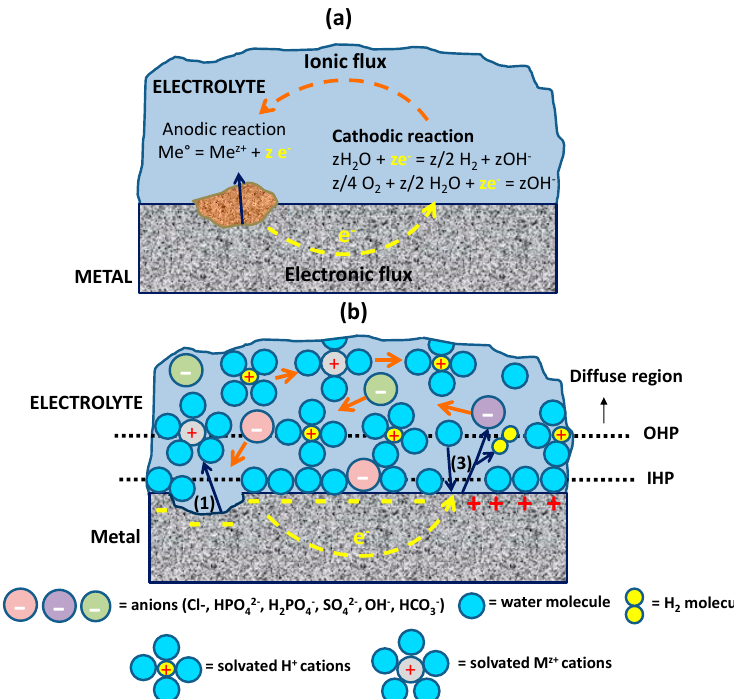
Figure 4. Scheme illustrating ( a ) the electrochemical corrosion process at a metal or alloy surface; ( b ) double-layer structure on a corroding metal showing inner (IHP) and outer (OHP) Helmholtz planes and related flux of ions (anions toward anodic areas and cations toward cathodic areas) upon polarization. Electrochemical corrosion allows the spontaneous anodic polarization of some areas and cathodic of other areas of the metal–alloy surface.